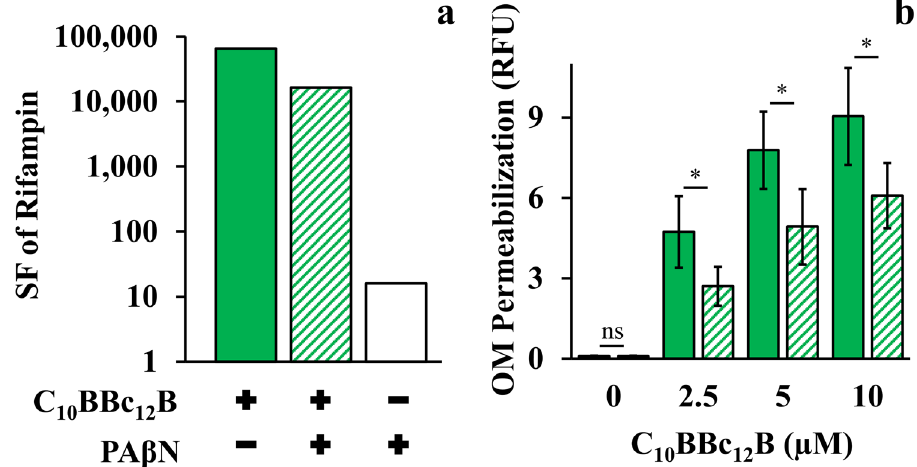
Figure 5. Efflux Role in C 10 BBc 12 B OM-Permeabilization Using E. coli 25922. ( a ) Sensitization factors (SF) determined for rifampin in presence of 10 µM C 10 BBc 12 B, solid green bars; 10 µM C 10 BBc 12 B + 5 µg/ml PAβN, striped green bars; 5 µg/ml PAβN, white bars. ( b ) OM permeabilization assessed using a modified NPN assay, following 5 min incubation with 100 µM CCCP. C 10 BBc 12 B, solid green bars, C 10 BBc 12 B in presence of 100 µM CCCP, striped green bars. Data represent fluorescence after 1 min. Asterisks denote P < 0.05; ns, not significant. RFU, relative fluorescence units. Error bars represent standard